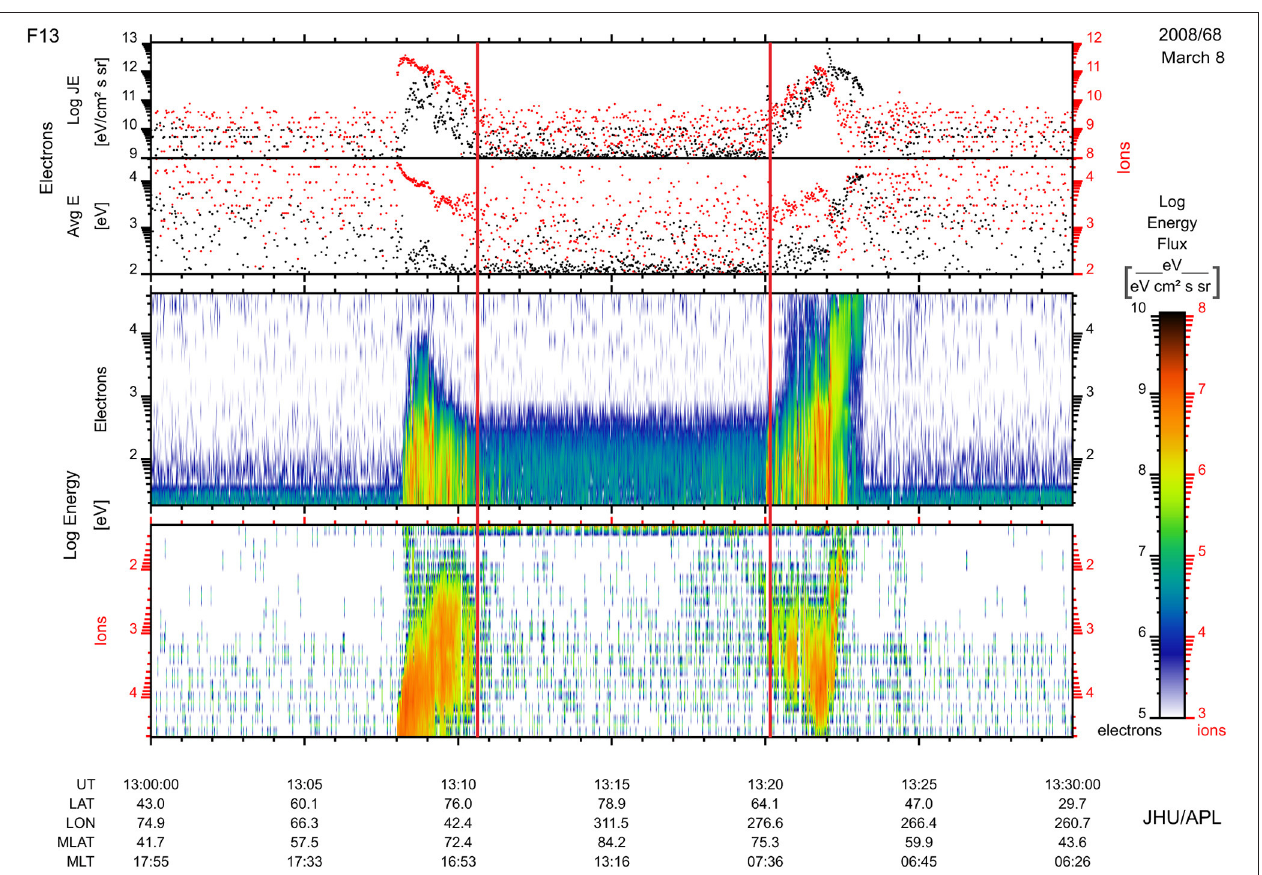
Frontiers in Physics |